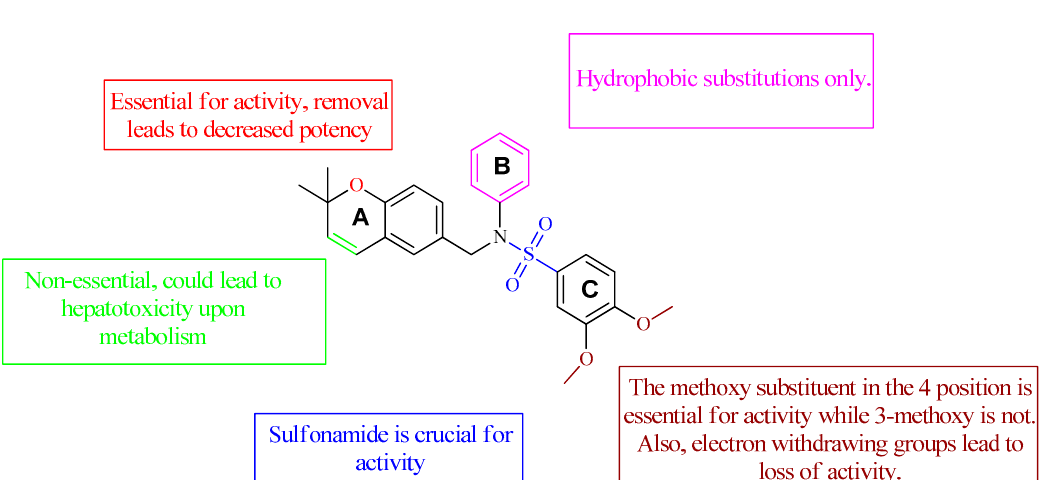
marized in Figure 7.